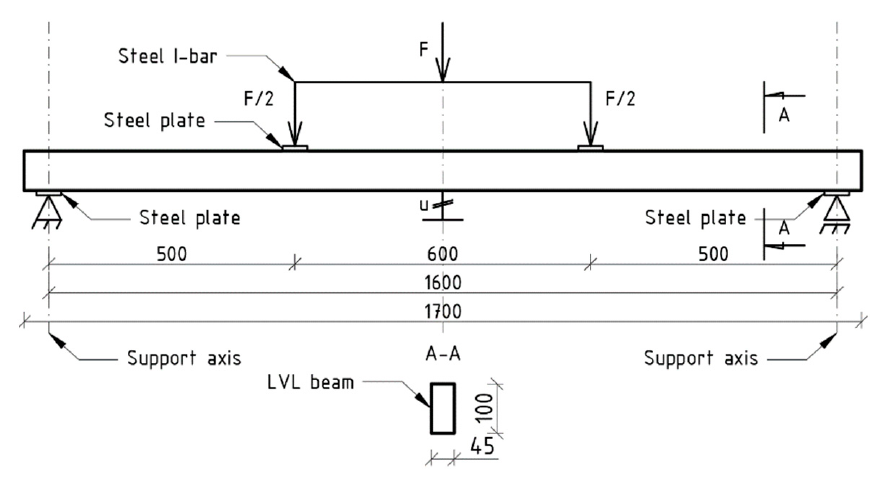
Figure 3. Static scheme.